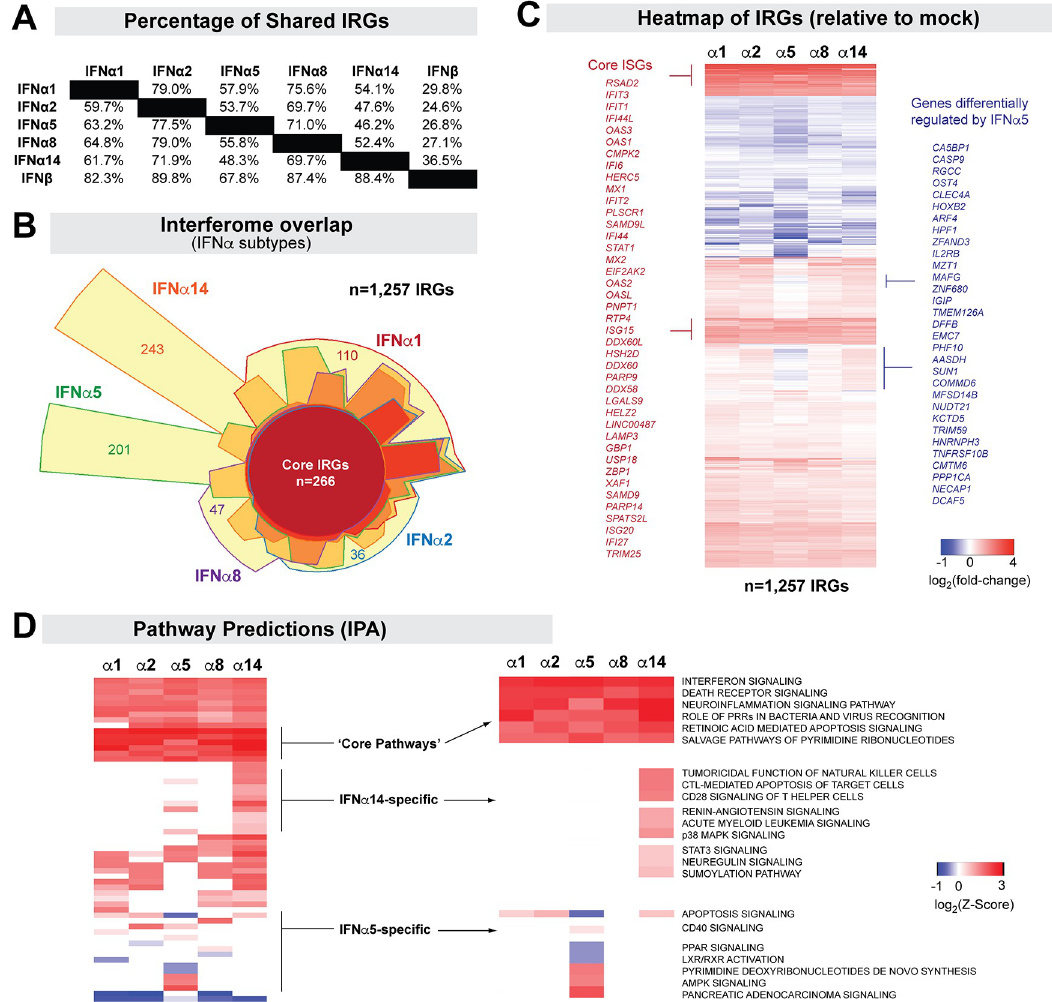
Fig 4. Interferome Differences between the IFN α subtypes. (A) Percentage of shared IRGs. The denominators used for the top diagonal half were the left column, whereas the denominators used for the lower diagonal half were the top rows. For example: 79.0% of IFN α 2-regulated genes were found among IFN α 1-RGs, whereas 59.7% of IFN α 1-RGs were found among IFN α 2-RGs. (B) Euler diagram showing the interferome overlap between the 5 IFN α subtypes tested. A core set of 266 IRGs altered by all 5 IFN α subtypes were detected. IFN α -subtype specific genes were highlighted (e.g., 243 for IFN α 14, 201 for IFN α 5). The total number of IRGs (n = 1,257) include genes not shown that were shared between 2 to 4 IFN α subtypes. (C) Heatmap of IRGs from distinct IFN α subtypes. Highlighted areas in red correspond to core ISGs, whereas those in blue correspond to genes differentially regulated by IFN α 5 relative to the four other IFN α subtypes tested. (D) Ingenuity Pathway Analyses of IFN α subtypes, highlighting Z-scores for shared pathways and those predicted to be specific to IFN α 5 and IFN α